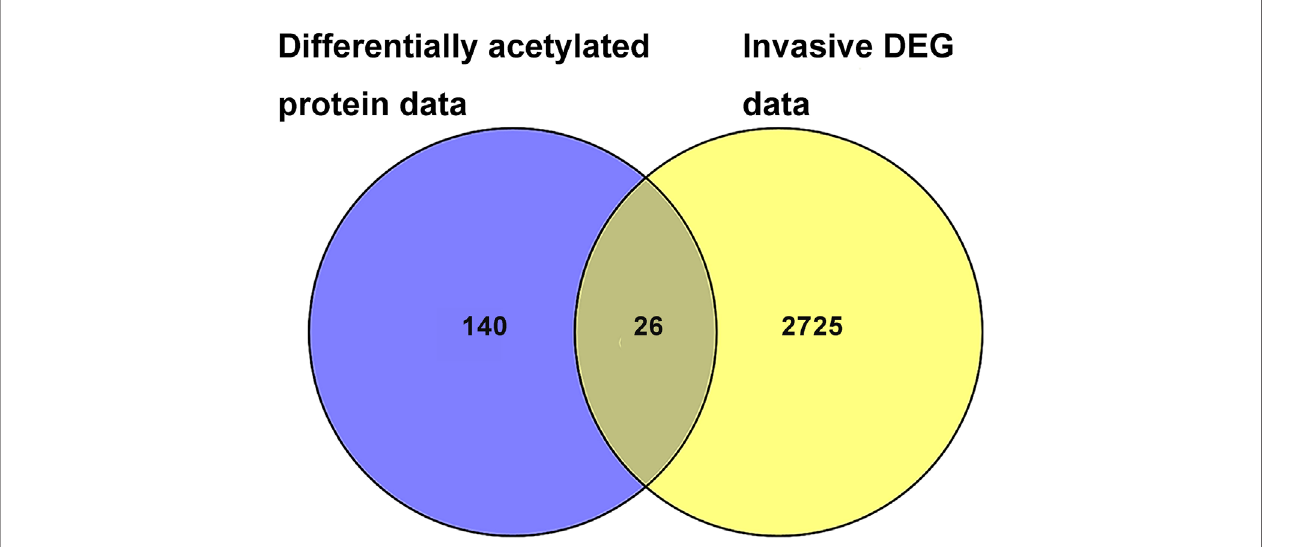
FIGURE 8 | The overlapping analysis between DAP data in NF-PitNETs vs. controls and DEG data in invasive NF-PitNETs vs. controls. The invasive DEG data were mined from the GEO